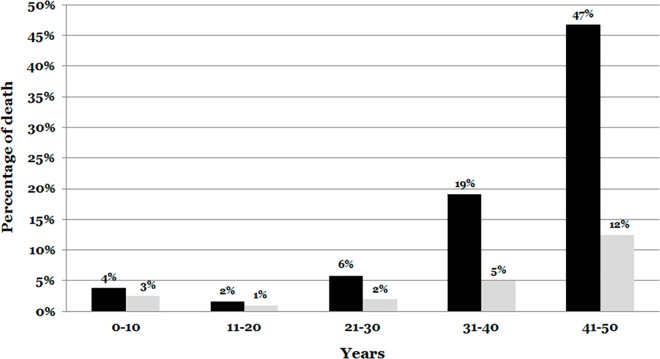
Percentage of natural death according to age and gender.The main percentage of death occurs in last range of ages. In all ranges of age, males are a high percentage of death. Males are indicated in black color. Females are indicated in white color.